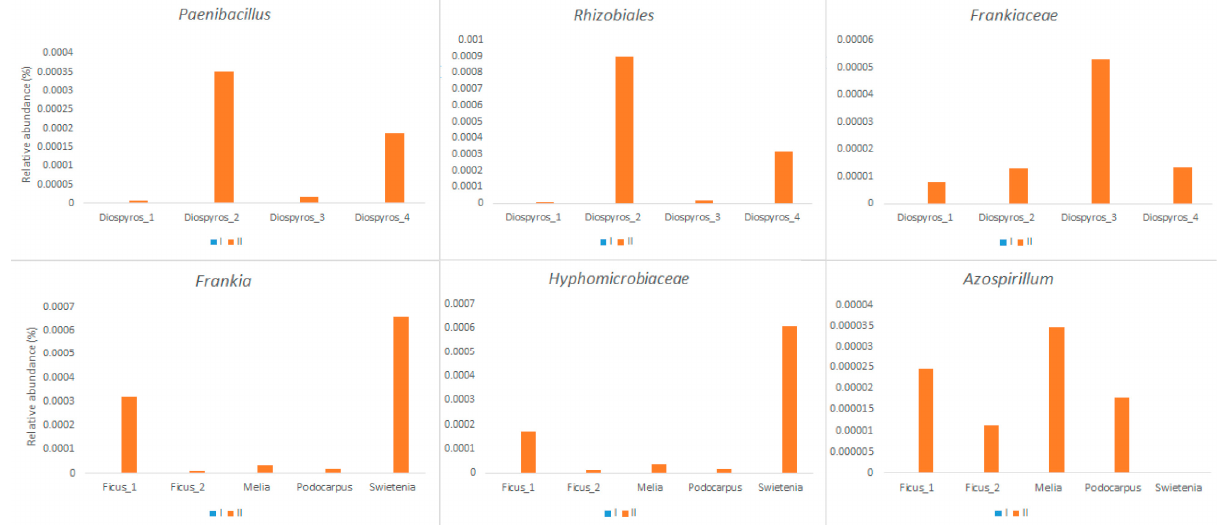
Figure 5. Potential nitrogen-fixing bacterial groups were detected in the rhizosphere soil after the amendment of biochar-based compost. Diospyros = D. blancoi , Swietenia = S. macrophylla , Melia = M. azedarach , Podocarpus = P. nakaii , and Ficus = F. microcarpa .